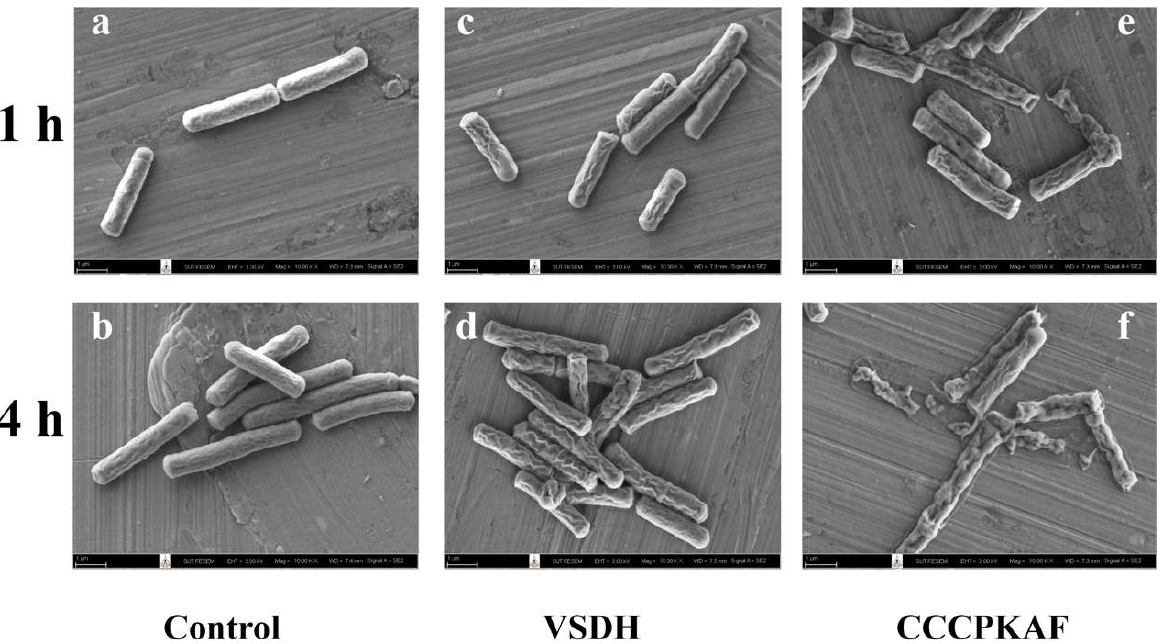
Figure 2. Morphological changes of B. cereus treated with 0.5 mM VSDH and 0.25 mM CCCPKAF Figure 2 . Morphological changes of B . cereus treated with 0.5 mM VSDH and 0.25 mM CCCPKAF equivalent to 1 × MIC, observed by scanning electron microscopy: Control 1 and 4 h ( a , b ); VSDH equivalent to 1 × MIC, observed by scanning electron microscopy : Control 1 and 4 h ( a , b ) ; VSDH 1 1 and 4 h ( c , d ); CCCPKAF 1 and 4 h ( e , f and 4 h ( c , d ) ; CCCPKAF 1 and 4 h ( e , f ).